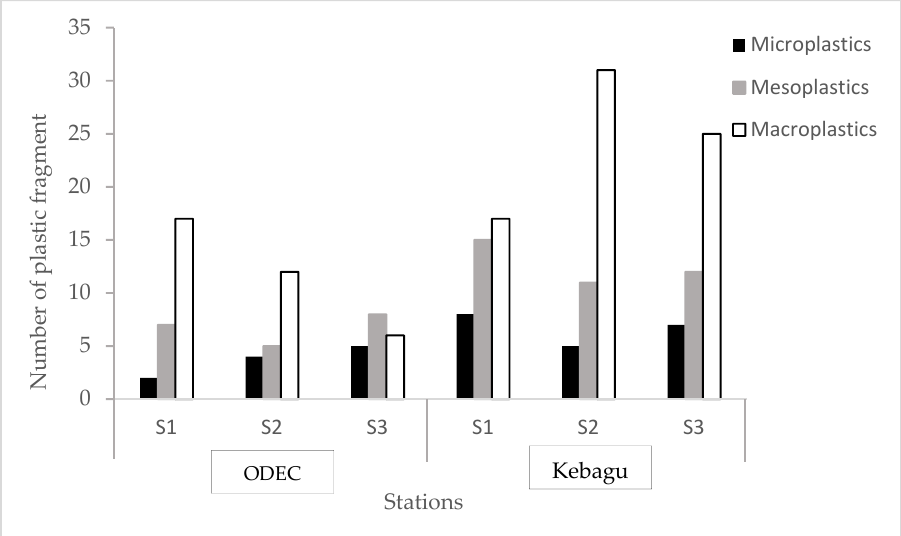
Figure 3. Size classification of plastic fragments recovered from intertidal zones of the two sampling Figure 3. stations .